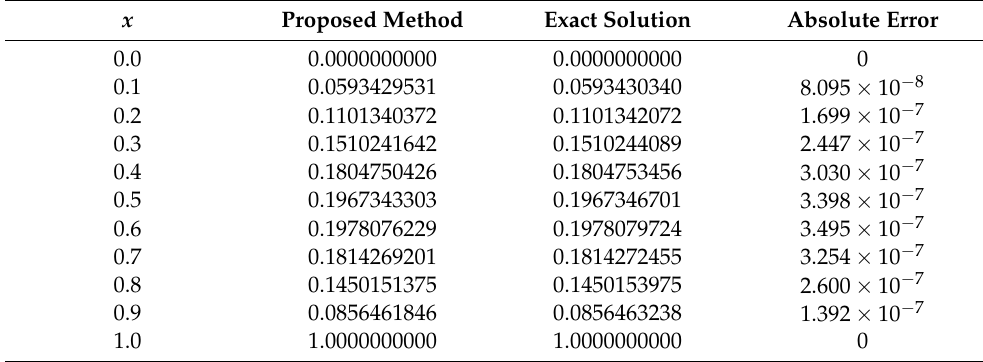
Table 2. Absolute errors for Problem 1 at h = 1/10.